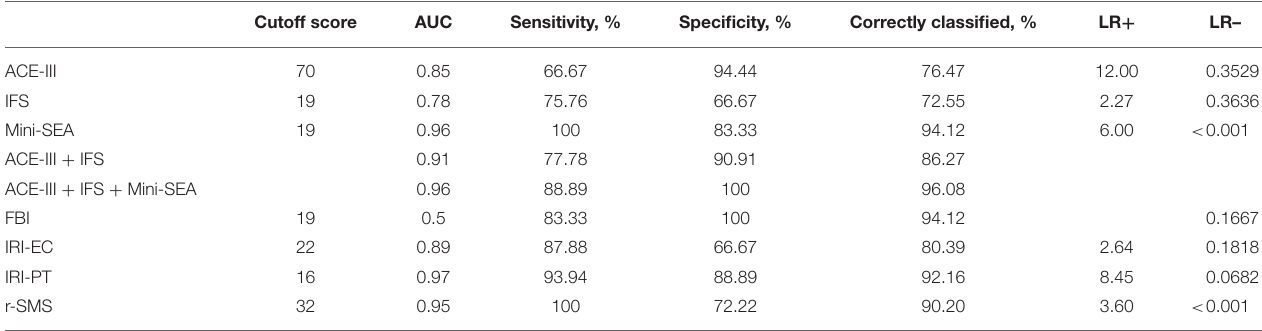
TABLE 2 | Baseline cutoff scores and diagnostic performance for the global cognition, social cognition, and behavioral tests to discriminate patients with Alzheimer’s disease and behavioral variant frontotemporal dementia (Instituto Peruano de Neurociencias, Lima, Peru; 2017–2020). Cutoff